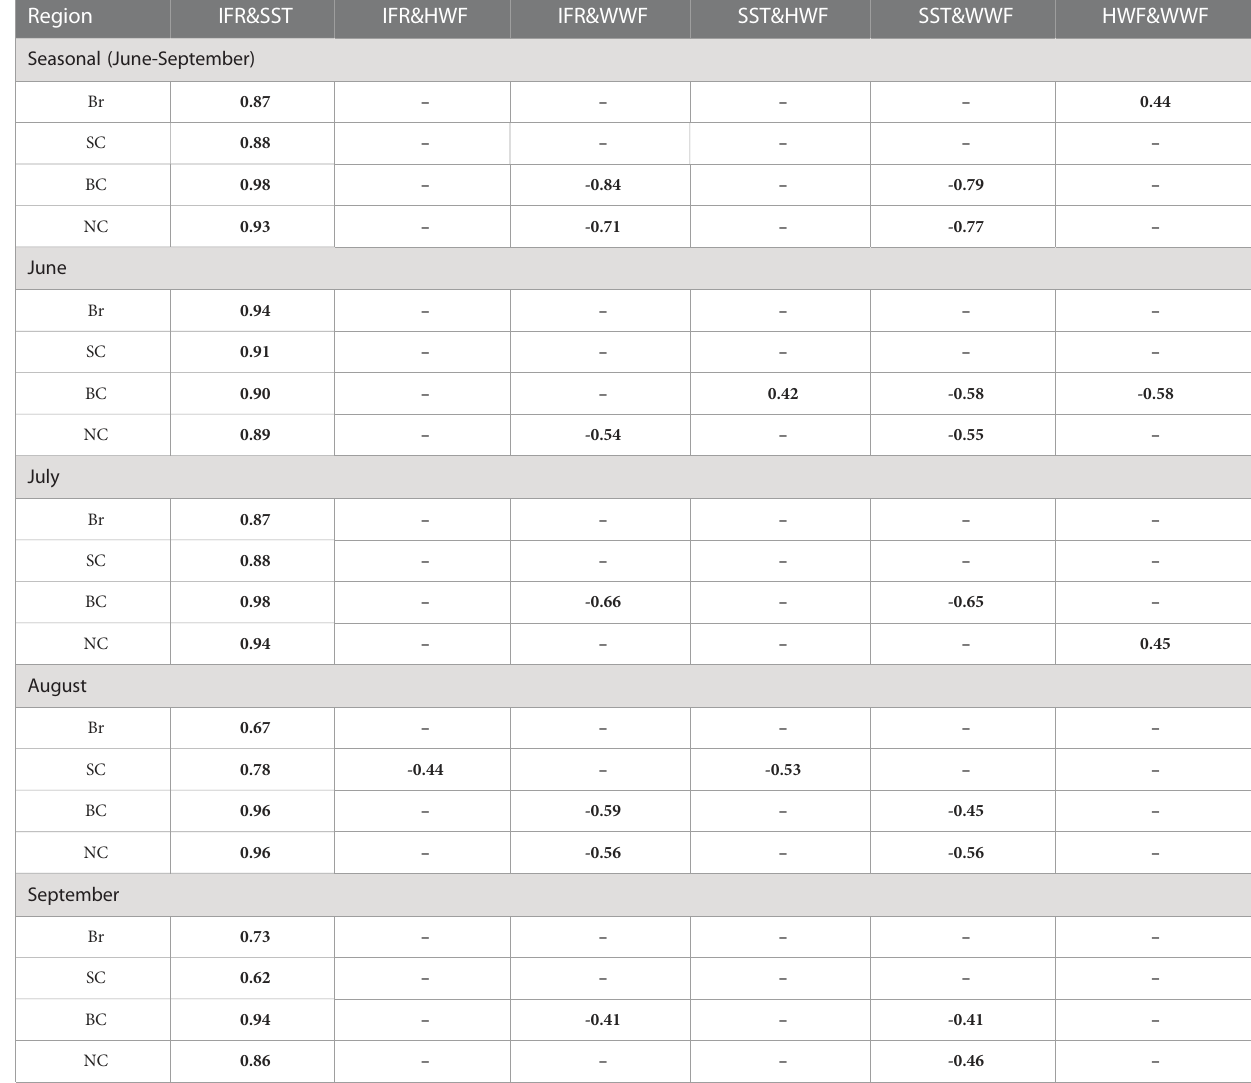
TABLE 2 Correlation coef fi cients between the four dependent variables in Equation (1) on both seasonal and monthly scales.